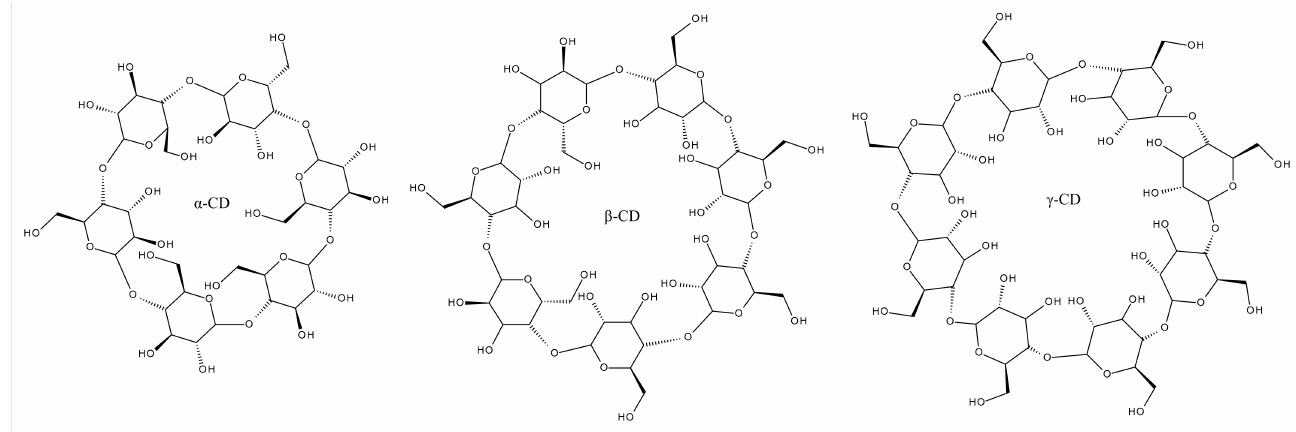
Figure 2. Structures of native cyclodextrins.